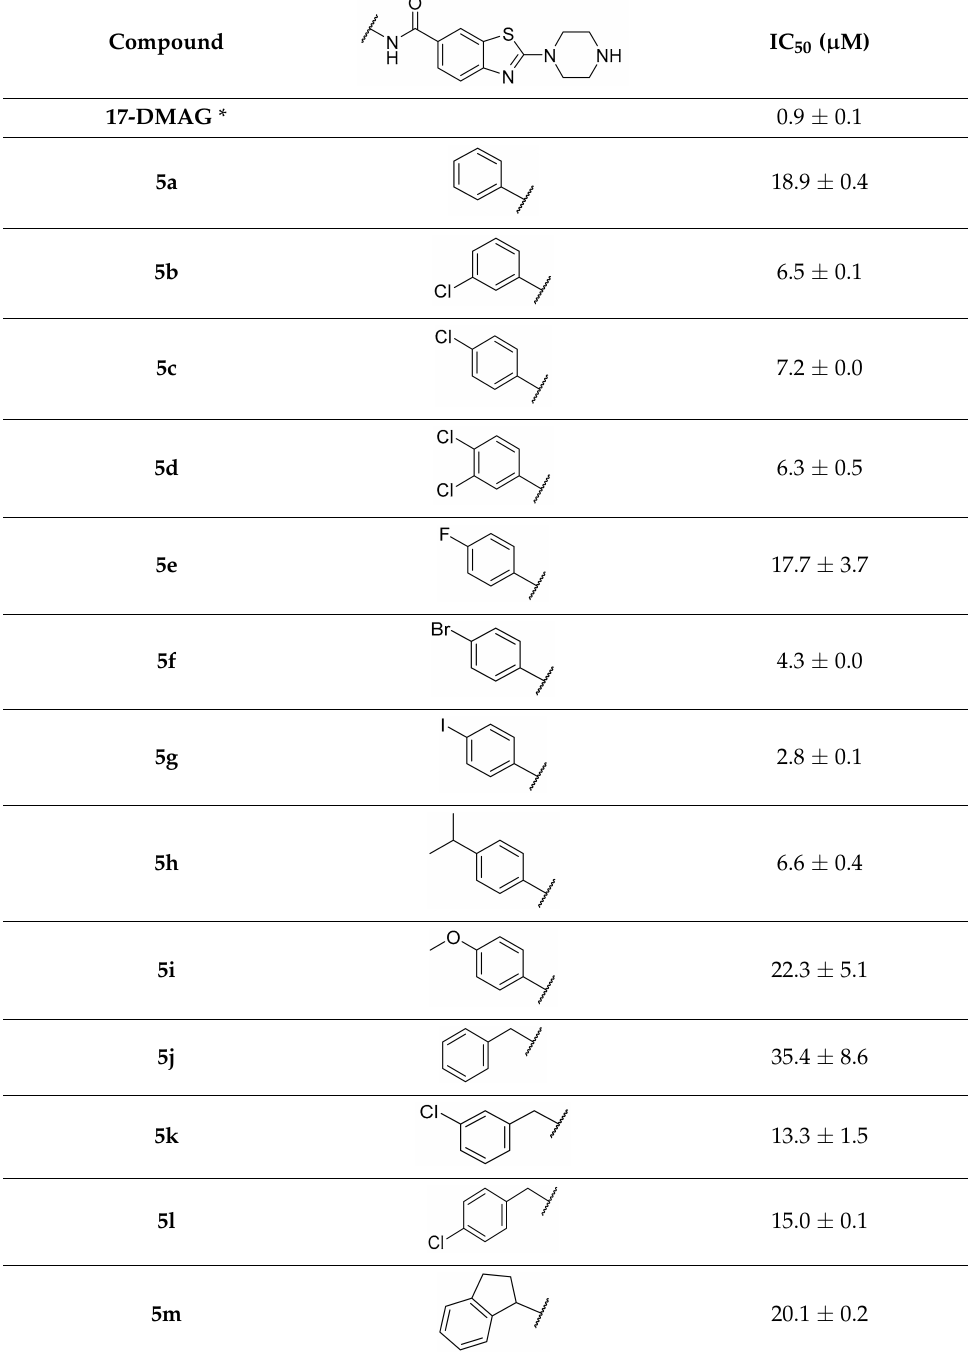
Table 1. IC 50 values for the antiproliferative activities of the synthesized benzothiazoles 5a – m in the MCF-7 breast cancer cell line: exploration of the structure–activity relationships at position 6 of the benzothiazole